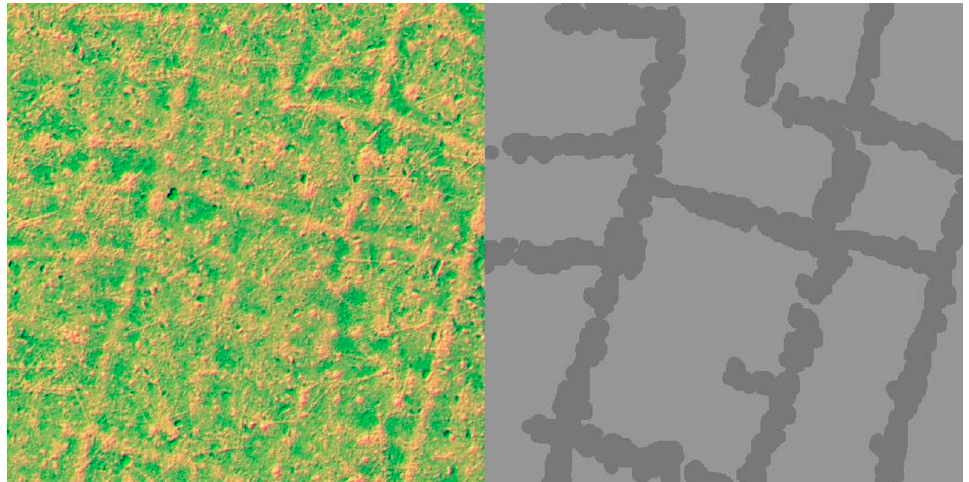
Figure 6. Example pair of an image and its ground truth mask (Celtic fields).